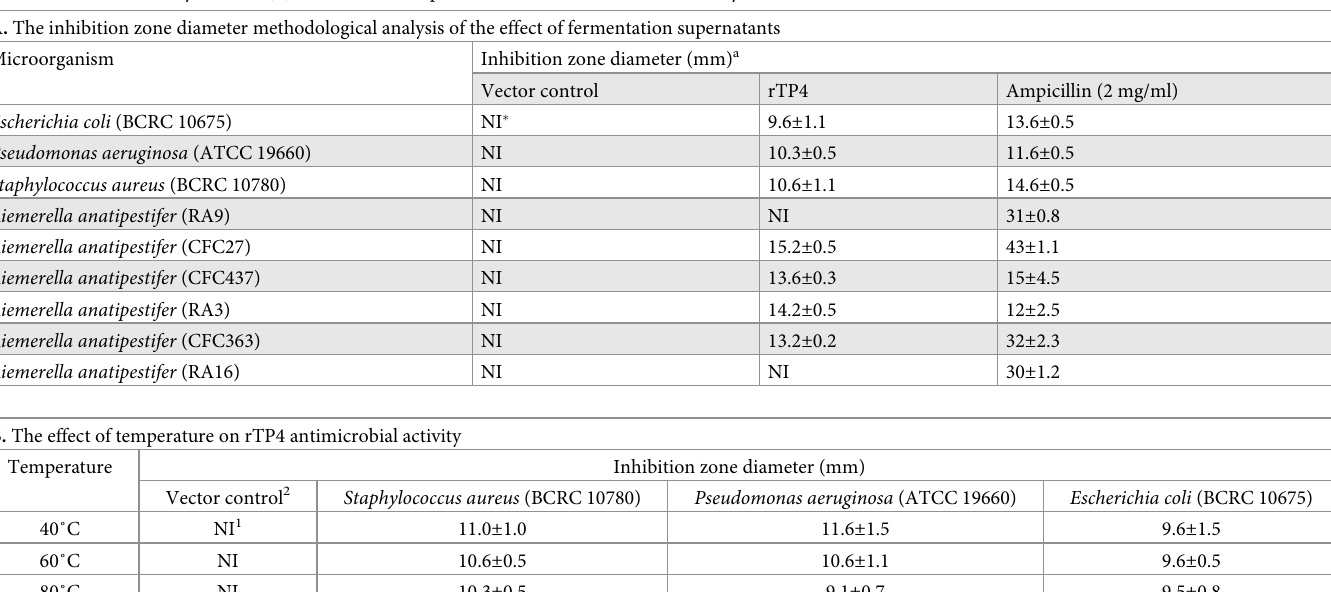
Table 1. The antimicrobial activity and effect of temperature of rTP4. The rTP4 was expressed by P . pastoris X-33 and supernatant were collected after induction and applied to disk diffusion assay. After incubation, the inhibition zone diameters were measured on the culture plate. Representative radial diffusion assays are shown. (A) The antimicrobial activity of rTP4. (B) The effect of temperature on rTP4 antimicrobial activity. A. The inhibition zone diameter methodological analysis of the effect of fermentation supernatants